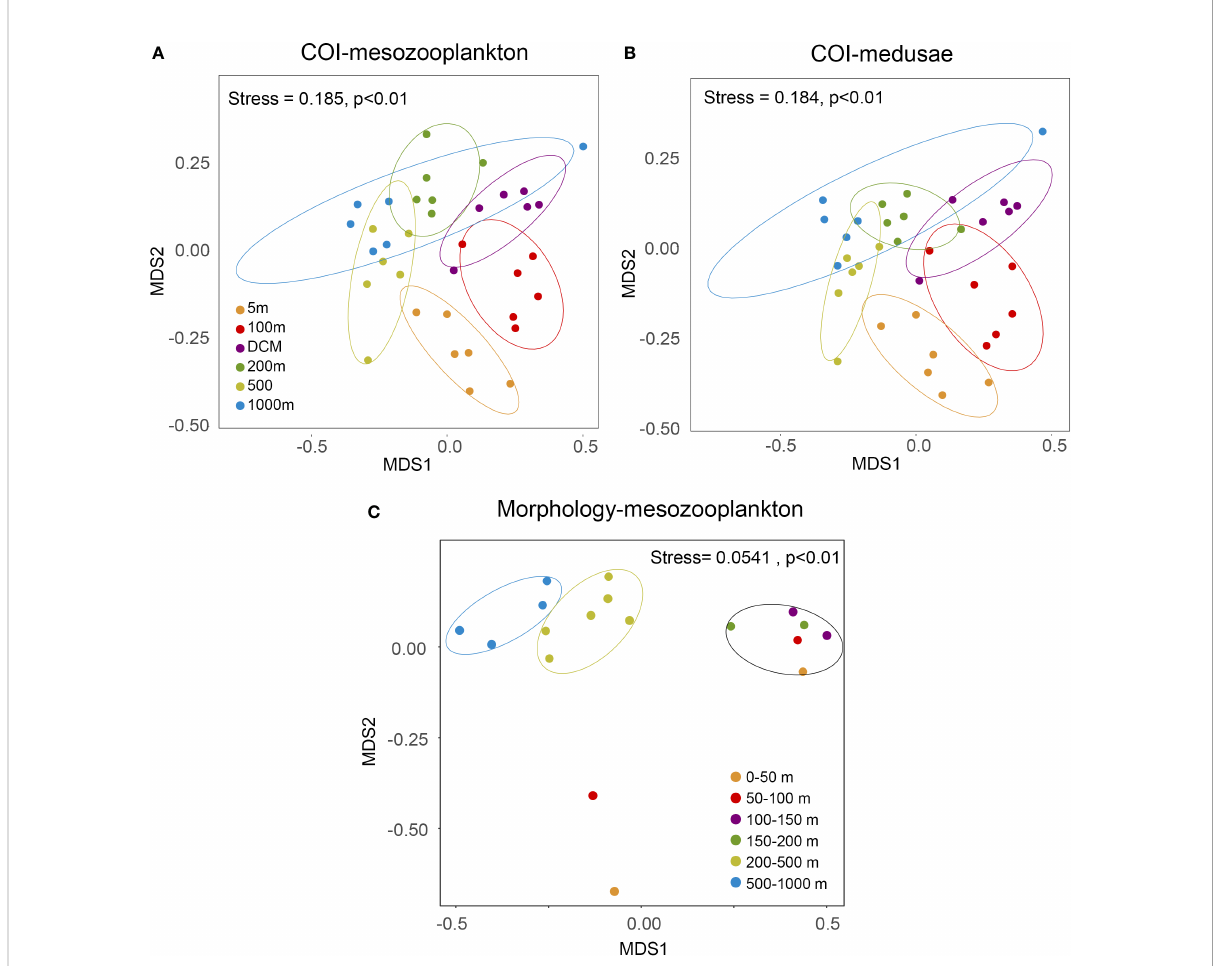
FIGURE 6 Nonmetric multidimensional scaling (NMDS) plots of (A) COI-mesozooplankton, (B) COI-medusae, and (C) morphology-mesozooplankton. The PERMANOVA was applied to test for signi fi cant differences in mesozooplankton